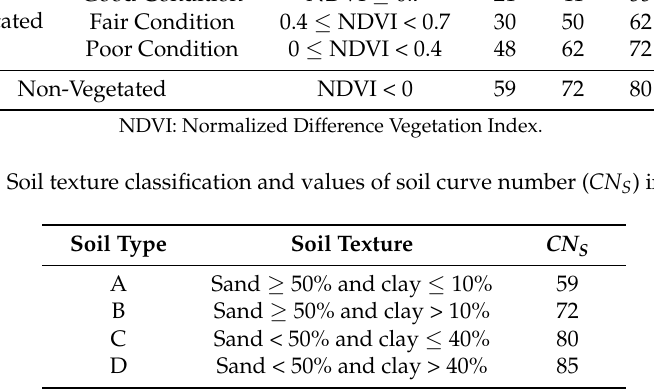
Vegetation Type NDVI Range Good Condition NDVI ≥ 0.7 Vegetated